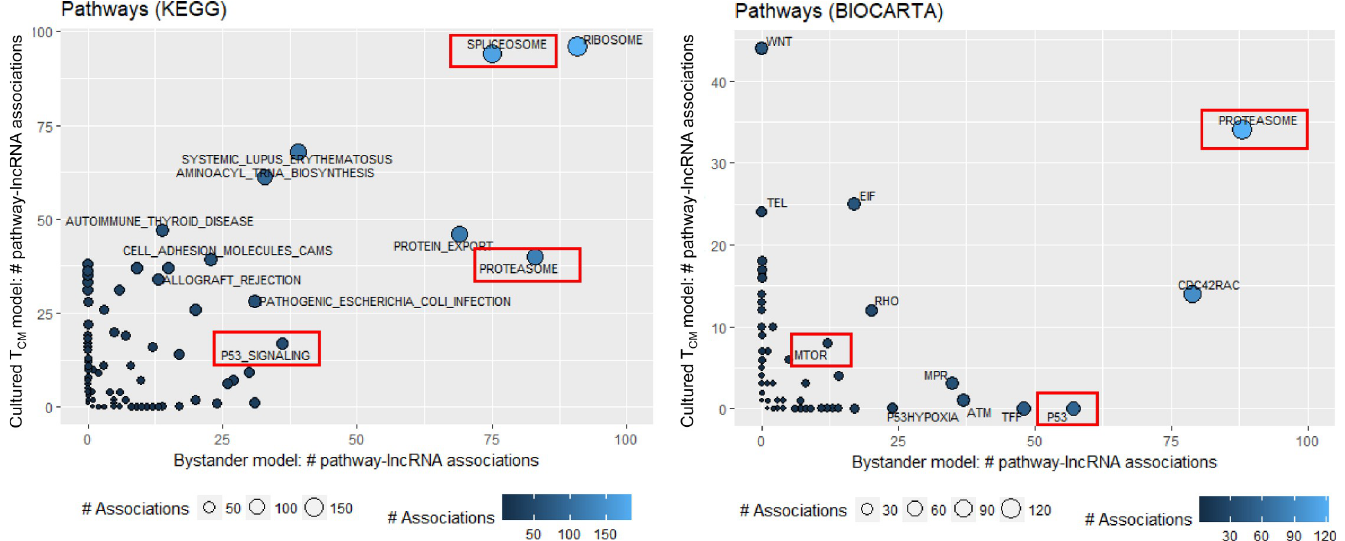
Fig 4. Pathways associated with lncRNA dysregulated in latency, identified by the guilt-by-association (GBA) analysis. Expression of lncRNAs dysregulated in latency (EdgeR’s FDR corrected p -value < 0.05) was correlated with expression of all detected mRNAs. A ranked mRNA gene list was constructed for each lncRNA based on their correlation coefficients and used as input for gene set enrichment analysis (GSEA) with KEGG and Biocarta pathway databases. A lncRNA was considered significantly associated to a pathway when the GSEA FDR corrected p -value was less than 0.05. Number of lncRNA pathway associations is shown on the X- axis for the bystander model and Y-axis for cultured T CM model, color-coded with blue shades and indicated by the size of the circle (lighter blue color and larger circle size correspond to the greater number of associations). Ribosome and spliceosome pathways have the most associations with dysregulated lncRNAs in both models. Pathways that line up along the X axis were identified for the bystander model dataset only; while pathways that line up along the Y axis were identified for the cultured T CM model only. Pathways relevant to HIV latency are highlighted by red